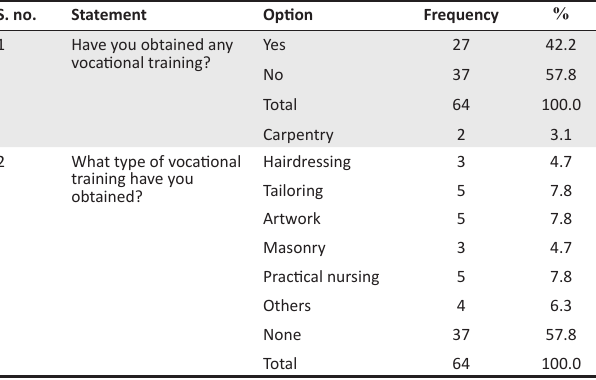
TABLE 3: Distribution of respondents’ responses on vocational training. S. no.